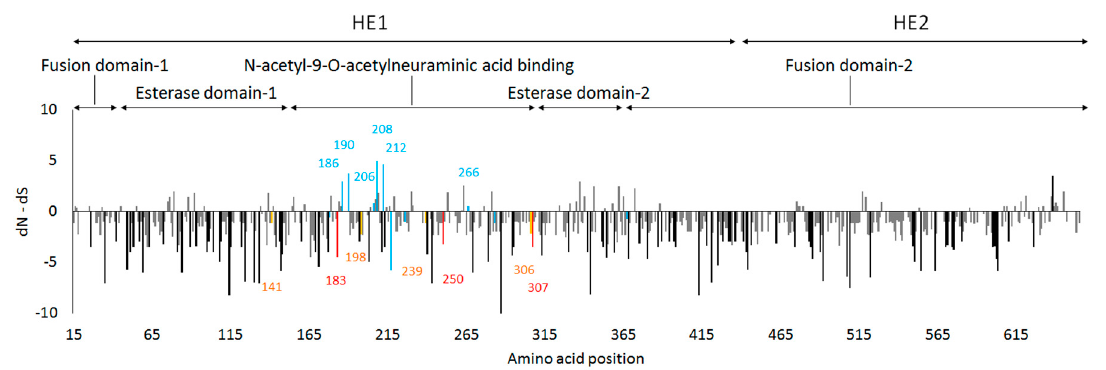
Figure 5. Site-by-site selection pressure for the HE gene of the influenza C virus. Selection pressure (relative number of non-synonymous substitutions minus synonymous substitutions (dN–dS)) on each codon is shown. Amino acid positions between 1 and 14 encoding signal peptides were excluded for the analysis. Selection pressure on antigenic sites (13 positions in total) is colored in blue. Selection pressure on receptor binding sites (11 positions in total) is colored in red (with statistical significance) and orange (no statistical significance). Black and gray bars indicate significant and non-significant selection pressure on the other positions, respectively. Amino acid positions were depicted with bars for antigenic sites under positive selection and receptor binding sites under negative selection.